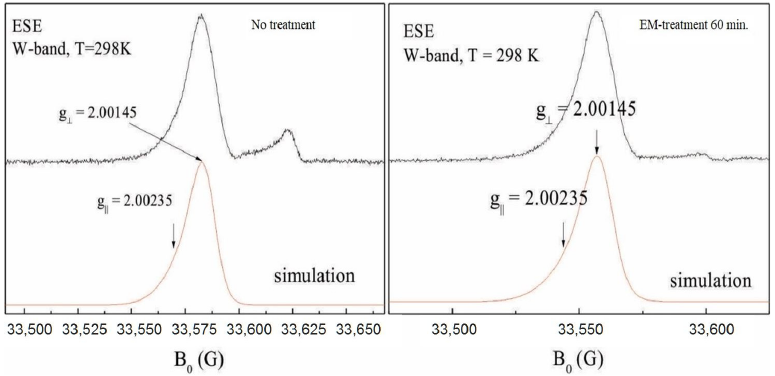
Figure 8. W-band EPR spectra and their simulations assuming the existence of a single axial symmetry center exhibiting two g-factor values: before ( left ) and after EM treatment ( right ).